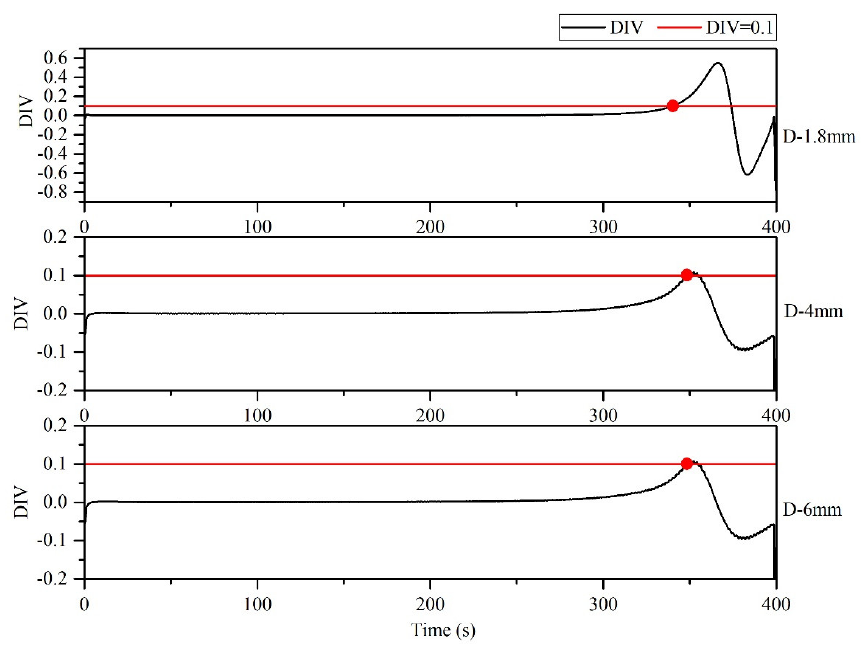
Figure 9. Polymer conversion rate curves under adiabatic conditions.